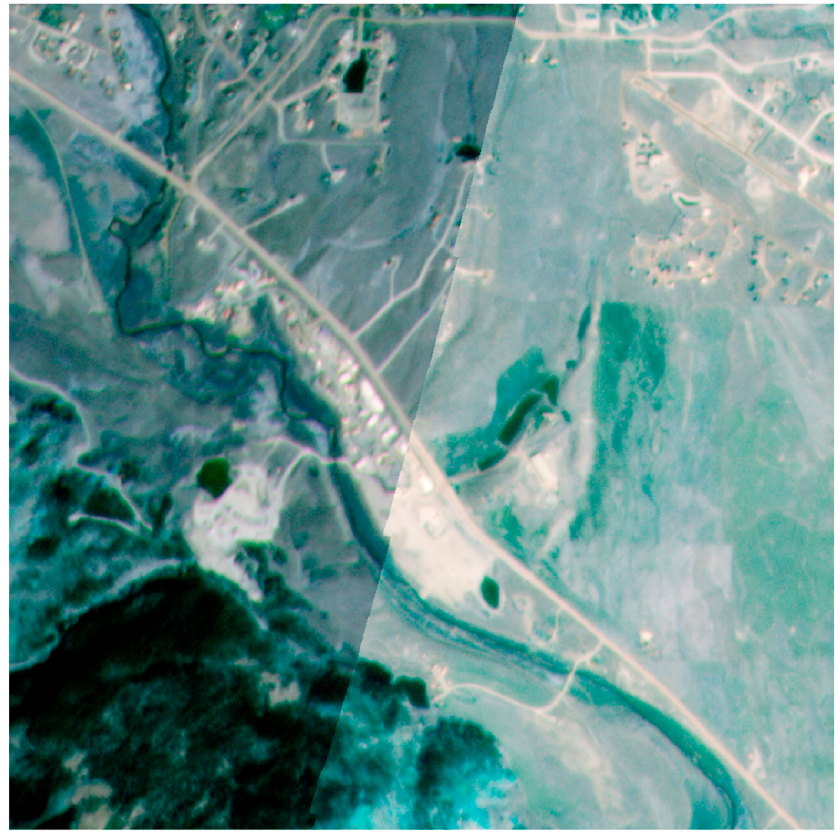
Figure 1. Example of scene-to-scene differences for two PlanetScope images captured on the same day (8 October 2020) by different smallsats in the constellation. Image captured near Crested Butte, CO, USA.